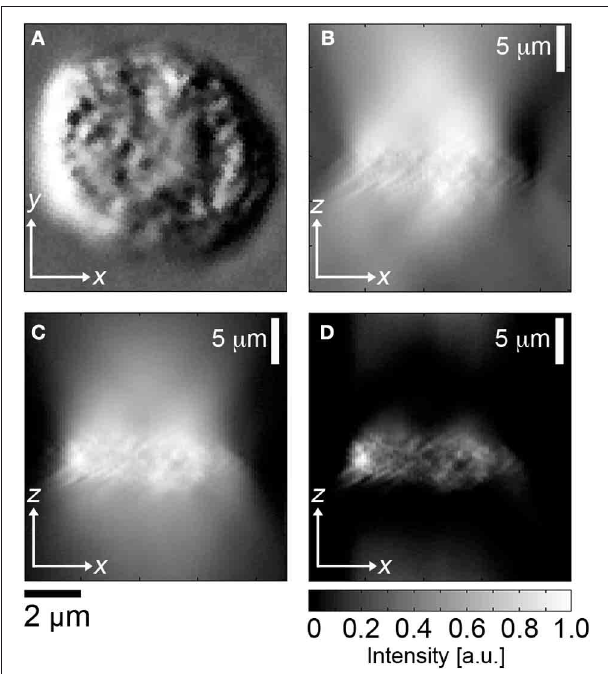
FIGURE 1 | Image segmentation of DIC image cubes. (A) En face DIC image, leukocyte, (B) corresponding cross sectional image through center of cell, (C) Hilbert transform of (B) , (D) high pass filter applied to (C) .